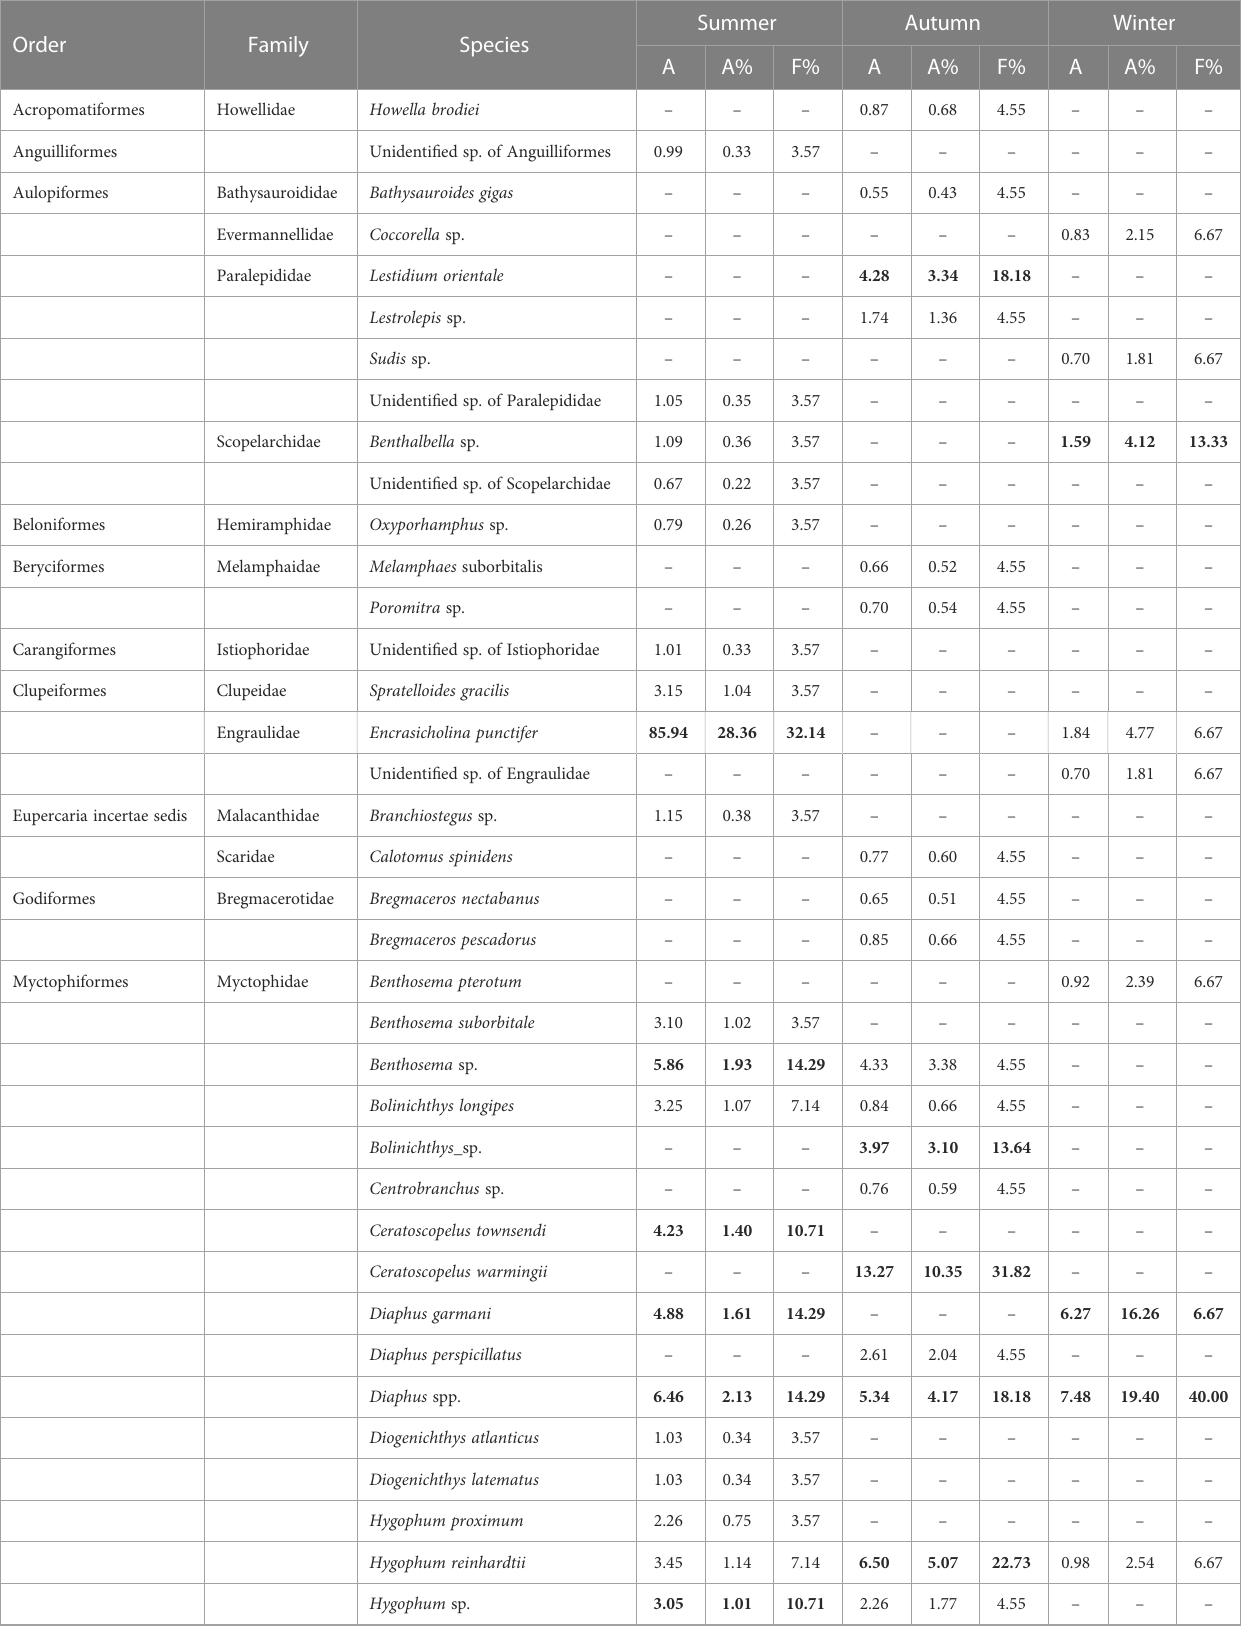
TABLE 1 The information of ichthyoplankton in the summer, autumn, and winter in the Philippine Sea, the main taxa (A % >10, or F %>10) are shown in bold.